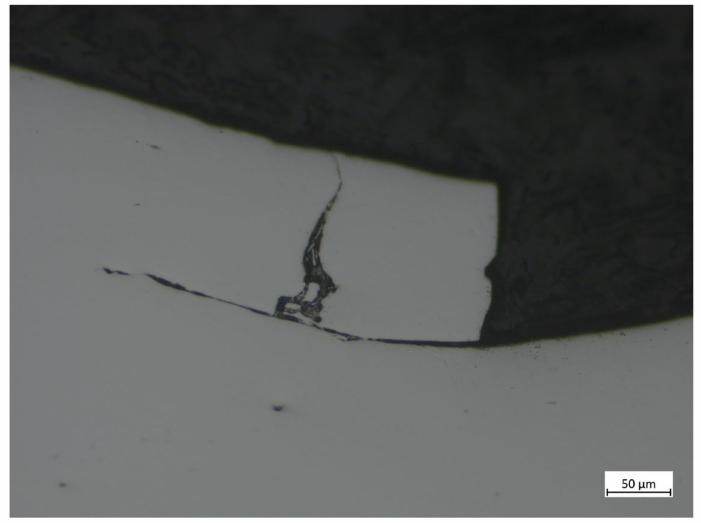
Figure 16. Spall propagation in the axial direction.